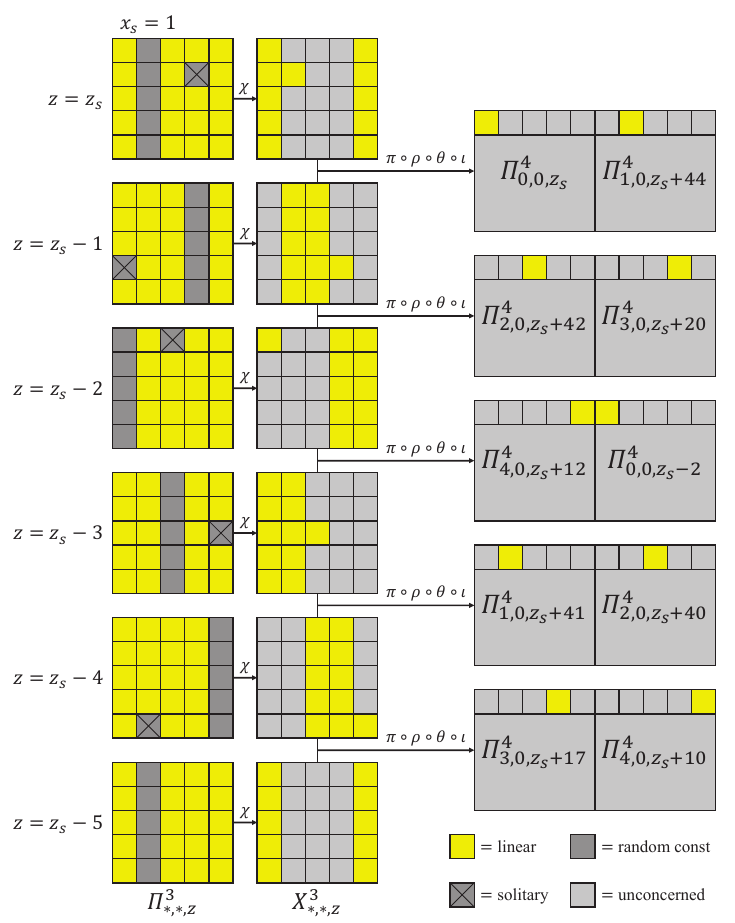
Figure 7: The freedom reuse strategy (one